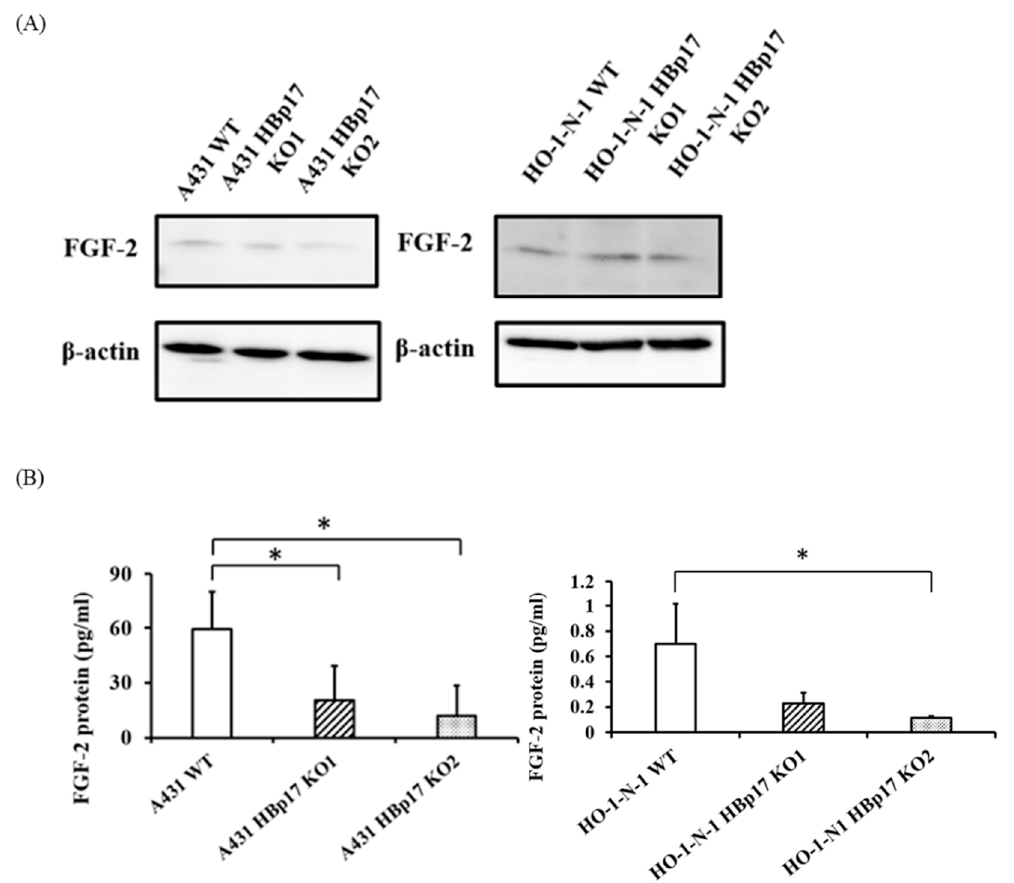
Figure 2. Decreased FGF-2 expression in HBp17-KO cell CM. ( A ) Western blot of FGF-2 in total cellular protein of A431- HBp17-KO1, -KO2, A431-WT, HO-1-N-1-HBp17-KO1, -KO2, and HO-1-N-1-WT cells. ( B ) ELISA of FGF-2 secreted into CM decreased for A431-HBp17-KO and HO-1-N-1-HBp17-KO cells compared to their WT counterparts. Each bar represents the mean + SD. * p < 0.05; n = 3.